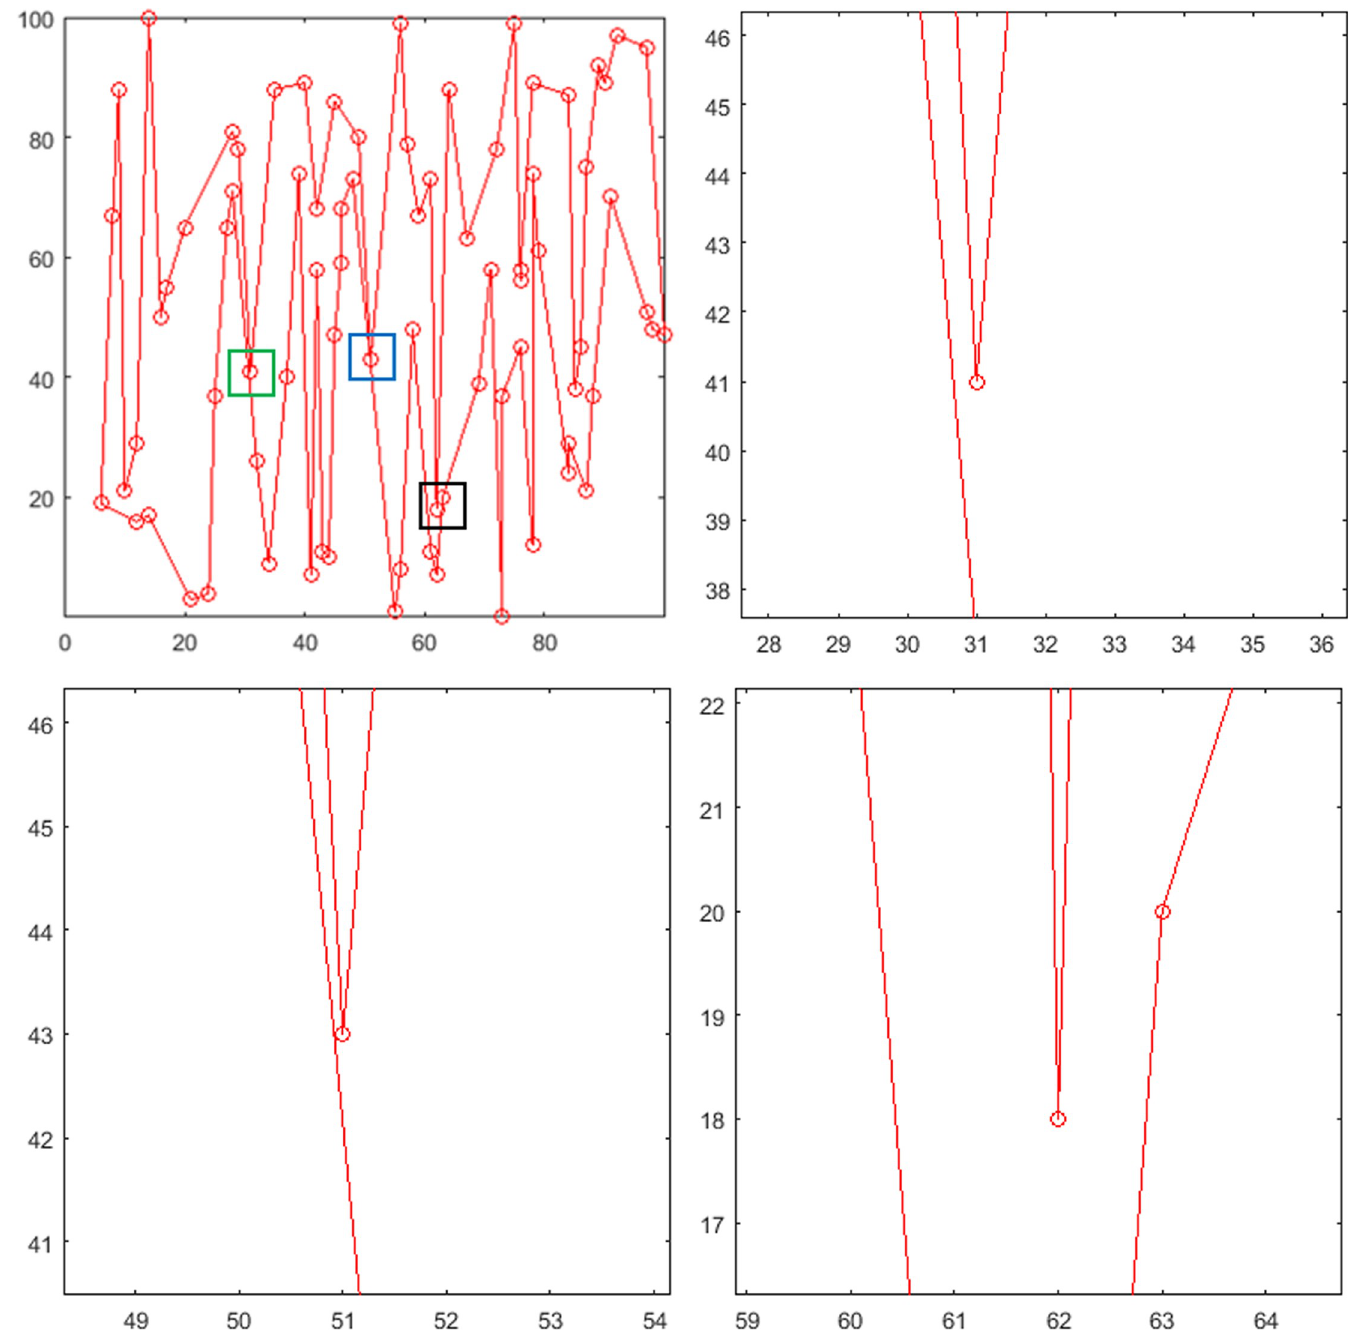
Fig 13. Polygon generation and magnification of partial areas. (a) Polygon consisting of 80 points, (b) enlarged area corresponding to the blue box, (c) enlarged area corresponding to the green box, and (d) enlarged area corresponding to the black area. https://doi.org/10.1371/journal.pone.0230342.g013 13(B)–13(D) represent enlarged images of areas in the blue, green, and black boxes in Fig 13 (A), respectively. We can see that the polygon with 80 random points is still a simple polygon. Moreover, the points in the graph are randomly generated, which verifies the feasibility of the proposed method for constructing simple polygons.